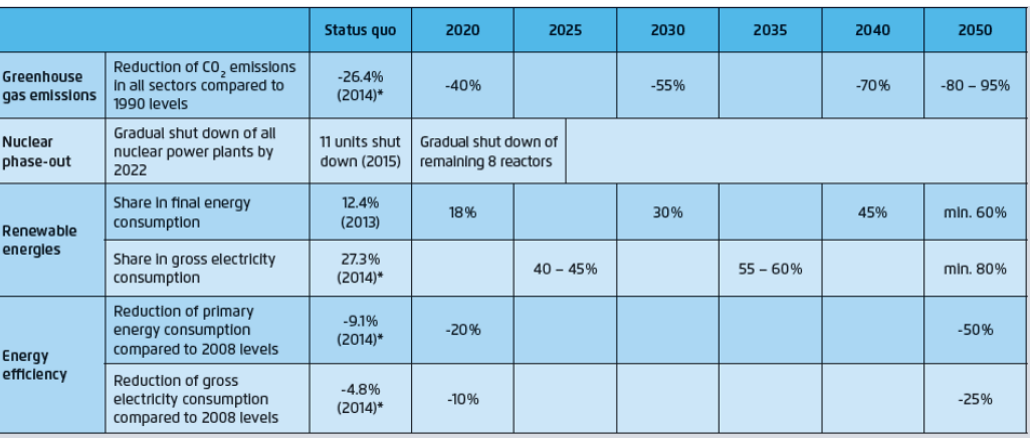
Figure 2. Main goals of Germany’s Energiewende . Source: [8] (p.